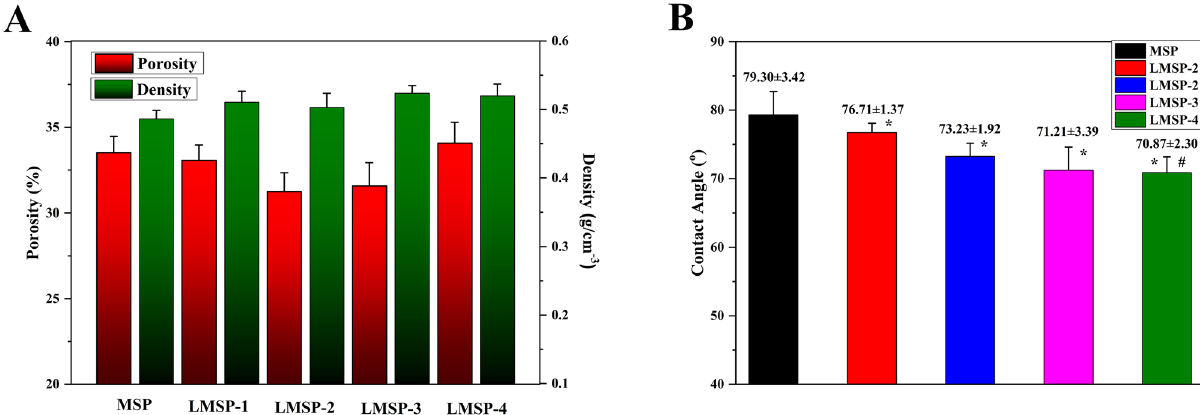
Figure 2. Porosity and density ( A ) and contact angle ( B ) of MSP and LMSP-1–4 scaffolds. (*) and (#) Indicates statistical significance when compared with the MSP and LMSP-1group, respectively (p < 0.05). MS